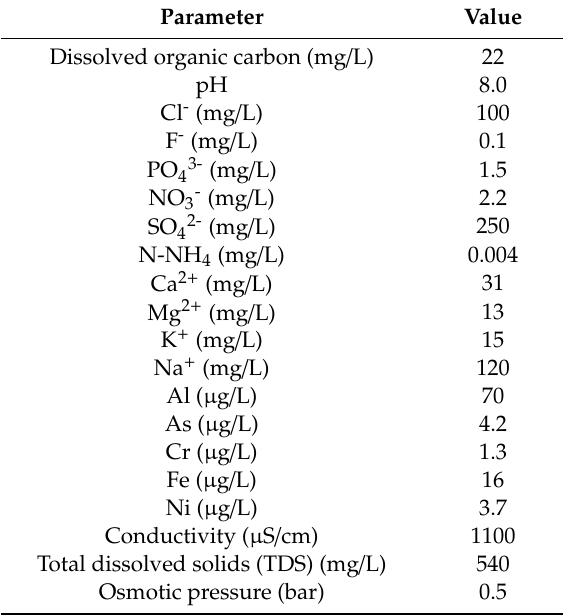
Table 1. Composition of the wastewater from the location of